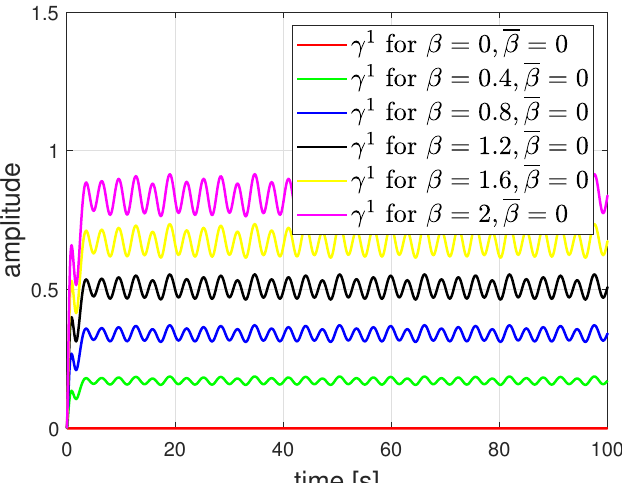
Figure 6. Residue signal of first detector when friction is not considered in the detector